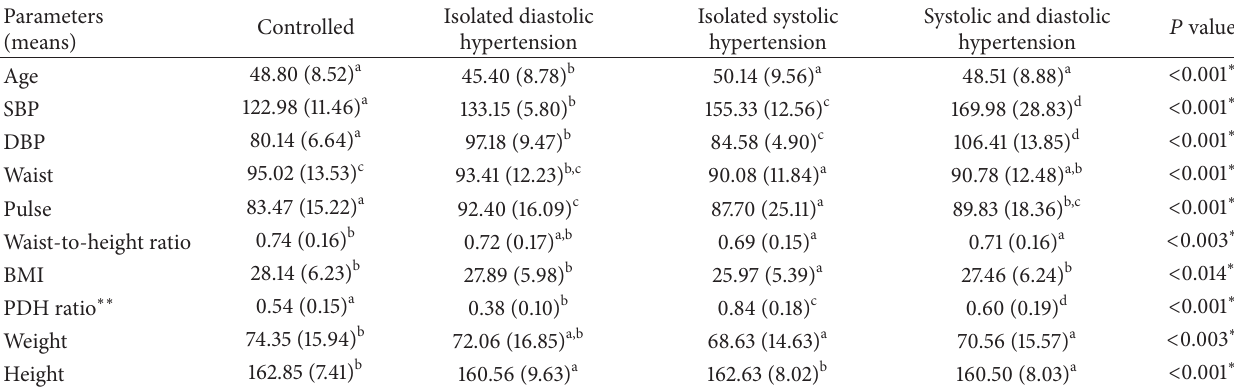
Table 3: Comparisons of demographic and BP indices in the hypertension